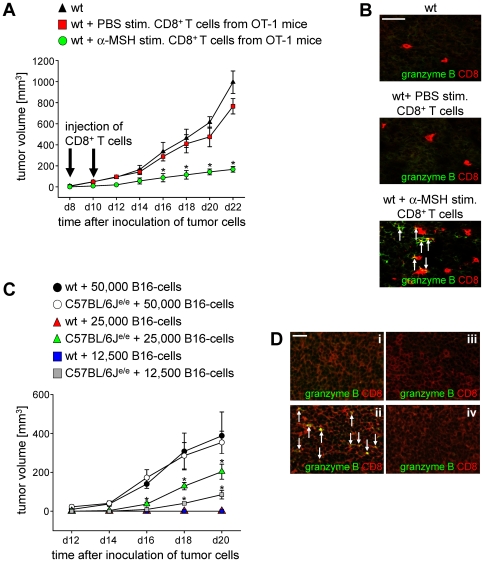
Reduced tumor growth in mice injected with α-MSH treated CD8+ T cells.(A) Wt mice were inoculated with 1×105 B16-OVA cells and injected with 5×106 PBS or α-MSH stimulated CD8+ T cells from OT-1 mice at d8 and d10 after inoculation of tumor cells. Tumor growth was monitored over time in n = 18 mice in three independent experiments. * P<0.05 vs. transfer of PBS stimulated CD8+ T cells. (B) Immunofluorescence staining of tumor tissue at d22 after inoculation of tumor cells using antibodies directed against CD8 and granzyme B. Original magnification: 400×, scale bar  = 25 µm. Cells expressing CD8 and granzyme B are marked by arrows. (C) MC-1R signaling is important for MHC class I-restricted anti-tumoral immunity. Wt and C57BL/6Je/e mice were inoculated with indicated concentrations of B16 cells and tumor growth was monitored over time. One representative out of three independent experiments is shown. * P<0.05 vs. wt. (D) Immunofluorescence staining of contralateral and tumor-draining lymph nodes from wt mice (i and ii) as well as C57BL/6Je/e mice (iii and iv) at d20 after inoculation of 25,000 B16 cells using antibodies directed against CD8 and granzyme B. Original magnification: 300×, scale bar  = 25 µm. Cells expressing CD8 and granzyme B are marked by arrows.